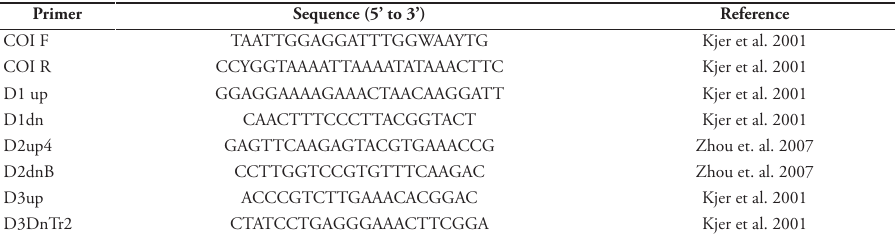
Table 3. Primers used in polymerase chain reactions for this study.